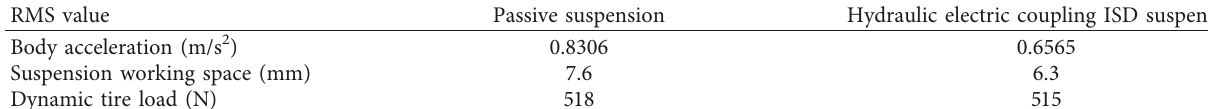
Table 7: Comparison of the RMS values of the suspension performance.